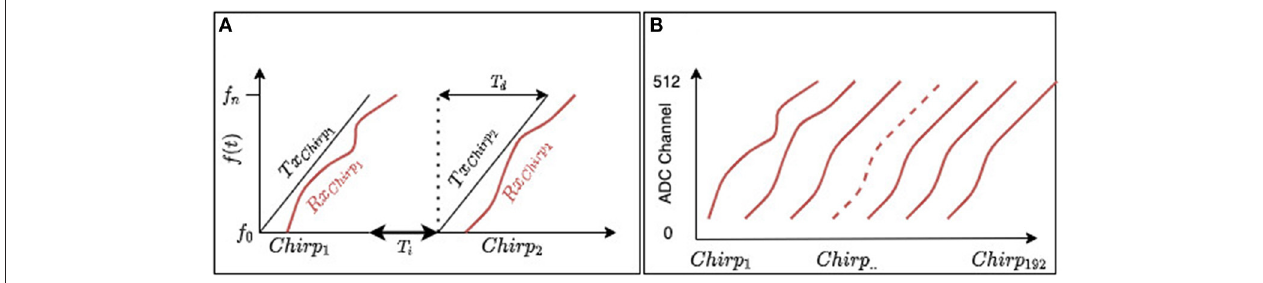
FIGURE 7 | FMCW SISO radar signal illustration. (A) A transmitter antenna transmits a signal of linearly increasing frequency starting at f 0 until f n . A receiving antenna captures back-scattered signal from the environment. T d represent chirp duration, while T i is the PRI (time interval) between chirps. (B) A radar frame is a collection of 192 consecutive chirp receptions.